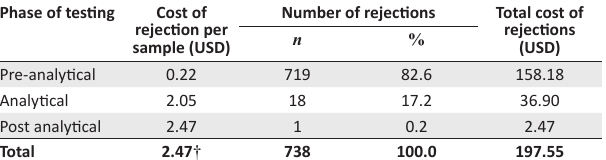
TABLE 4: Determining the total cost of rejections for HIV serology testing across the three phases of testing.